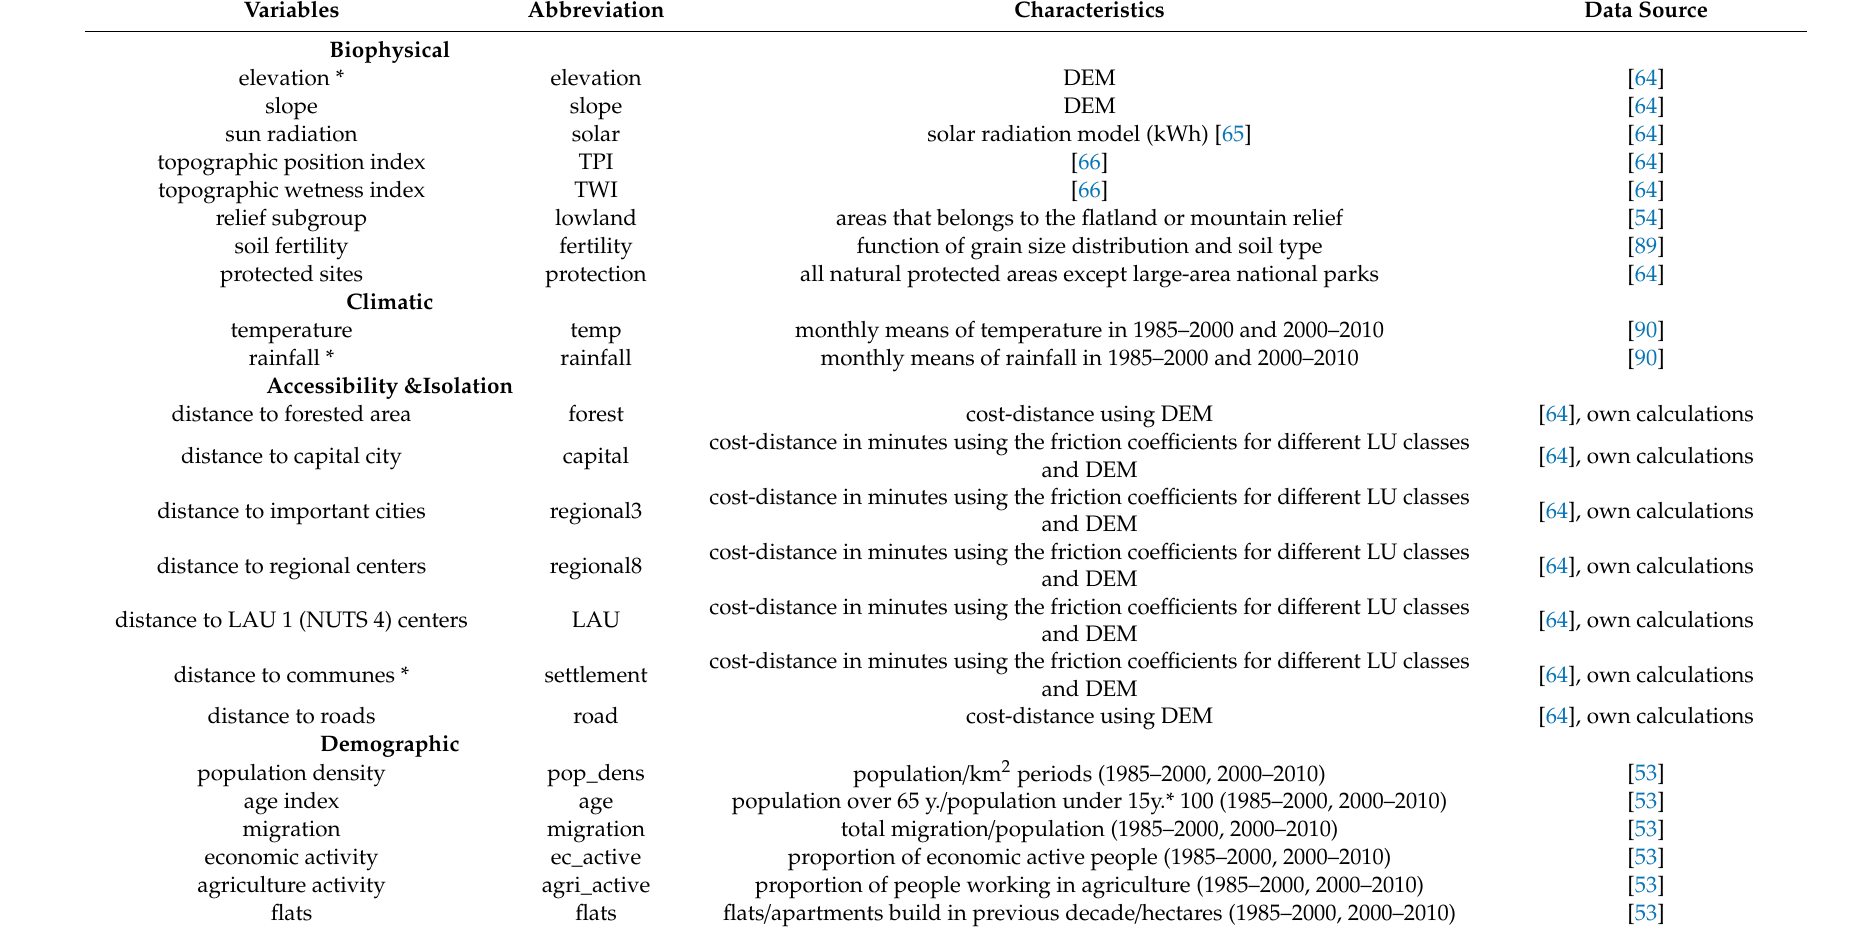
Table 1. Analyzed explanatory